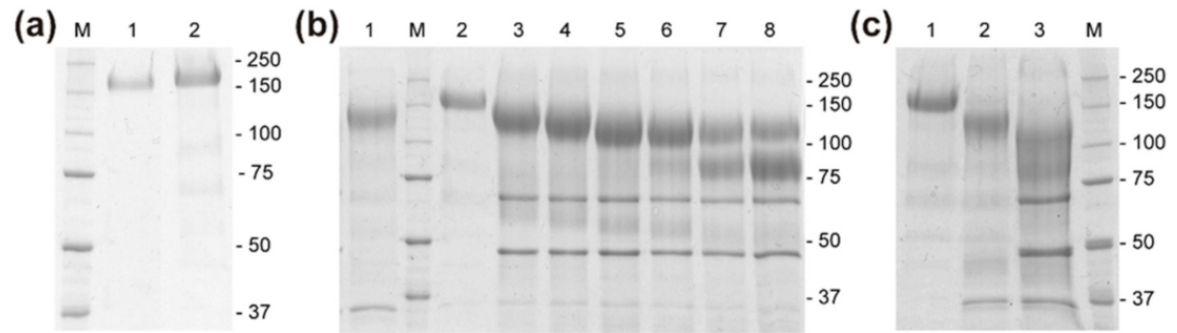
Figure 3. SDS-PAGE analysis of the purified β -fructofuranosidase RdINV and the deglycosylation treatment. ( a ) RdINV expressed in R. dairenensis (lane 1) and P. pastoris (lane 2). ( b ) The purified heterologous protein (lane 2) was treated with PNGase F (500 U) for 2 h (lane 1) or with mannosidase (2 U) during 1, 3, 8, 20, 48, and 72 h (lanes 3–8, respectively). ( c ) The heterologous protein (lane 1) was treated with PNGase F for 2 h (lane 2) and then with mannosidase for 7 h (lane 3). The positions of the molecular mass markers are indicated on the right in kDa. The theoretical molecular weight of PNGase F is 36 kDa and that of mannosidase 110 kDa, with two subunits of 66 and 44